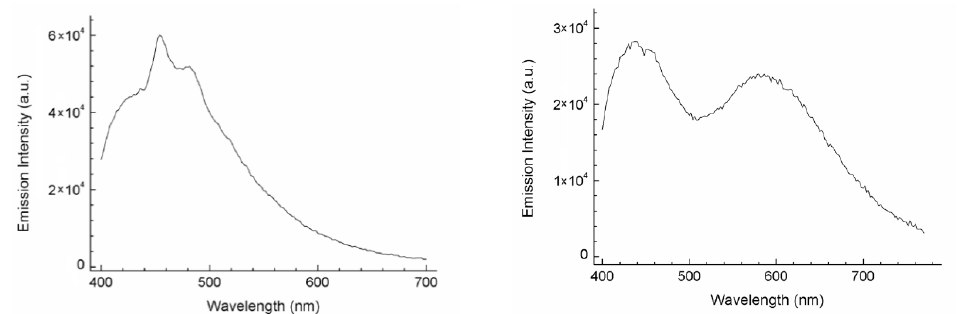
Figure 4. Real image of fabric samples under UV lamp ( λ em = 365 nm): uncoated ( A ), silica coated ( B ),